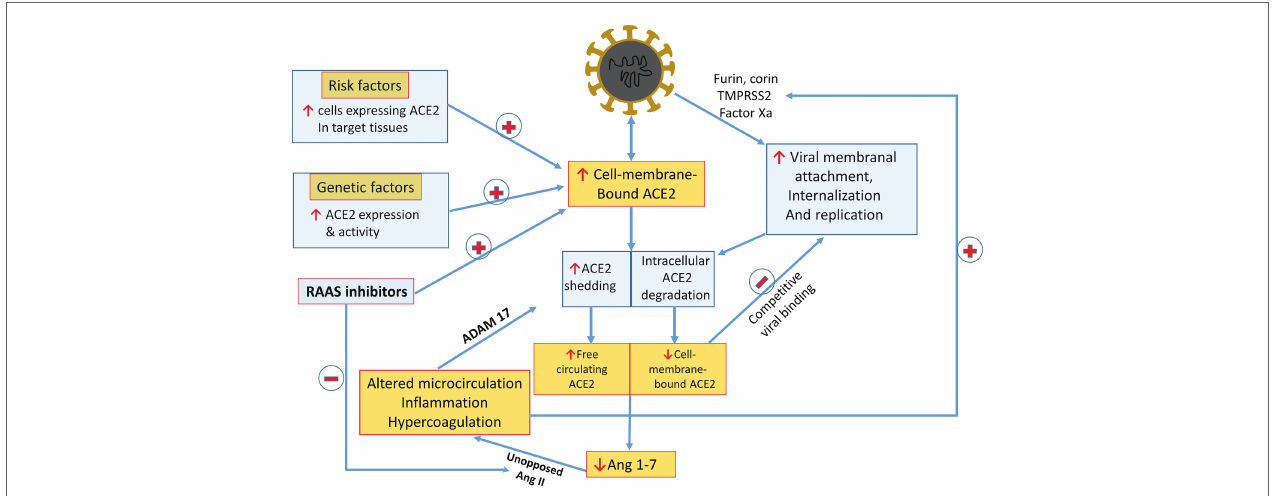
FIGURE 3 | A summarizing scheme of suggested COVID-17/RAS interactions: see text for details. Highlighted are factors enhancing ACE2 expression and viral binding to target host-cells, as are mechanisms leading to declining membranal ACE2 and Ang 1-7 synthesis. The impact of shedded sACE2 on tissue Ang 1-4 production and on inhibiting viral homing to target cells expressing ACE2 by means of competition require further elucidation. RAS inhibitors potentially can enhance viral invasion by enhancing ACE2 expression, yet they may attenuate the unfavorable outcome of Ang 1-7 depletion by a parallel inactivation of functionally opposing Ang II activity. Potential hazardous feed-forward loops are AT1R-mediated enhanced ACE2 shedding and intensification of viral attachment via proteases activated by vasoconstriction and ischemia, inflammation, and